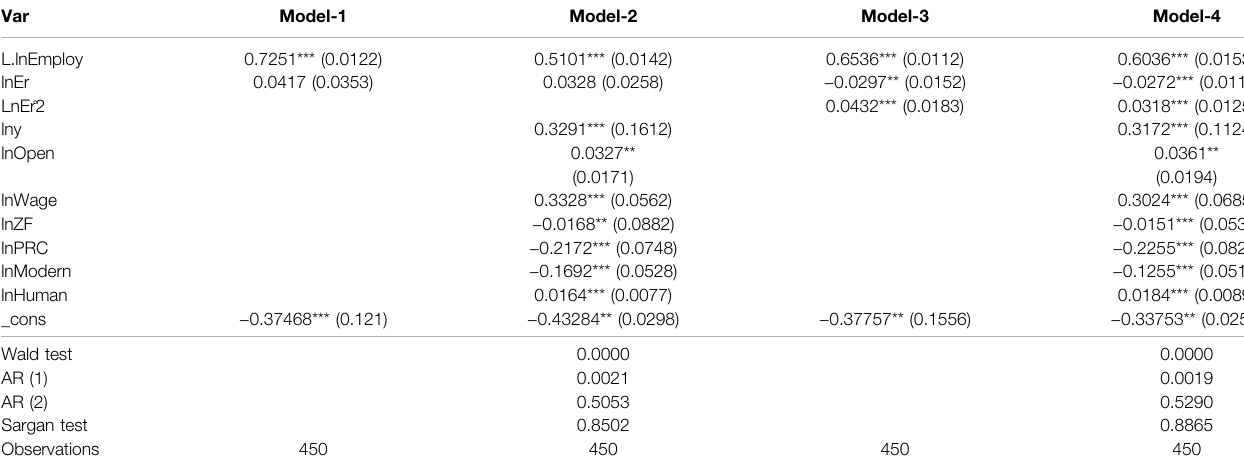
TABLE 3 | GMM estimation of the employment effect of carbon emission regulation. (Explained variable: lnEmploy; SYS-GMM,